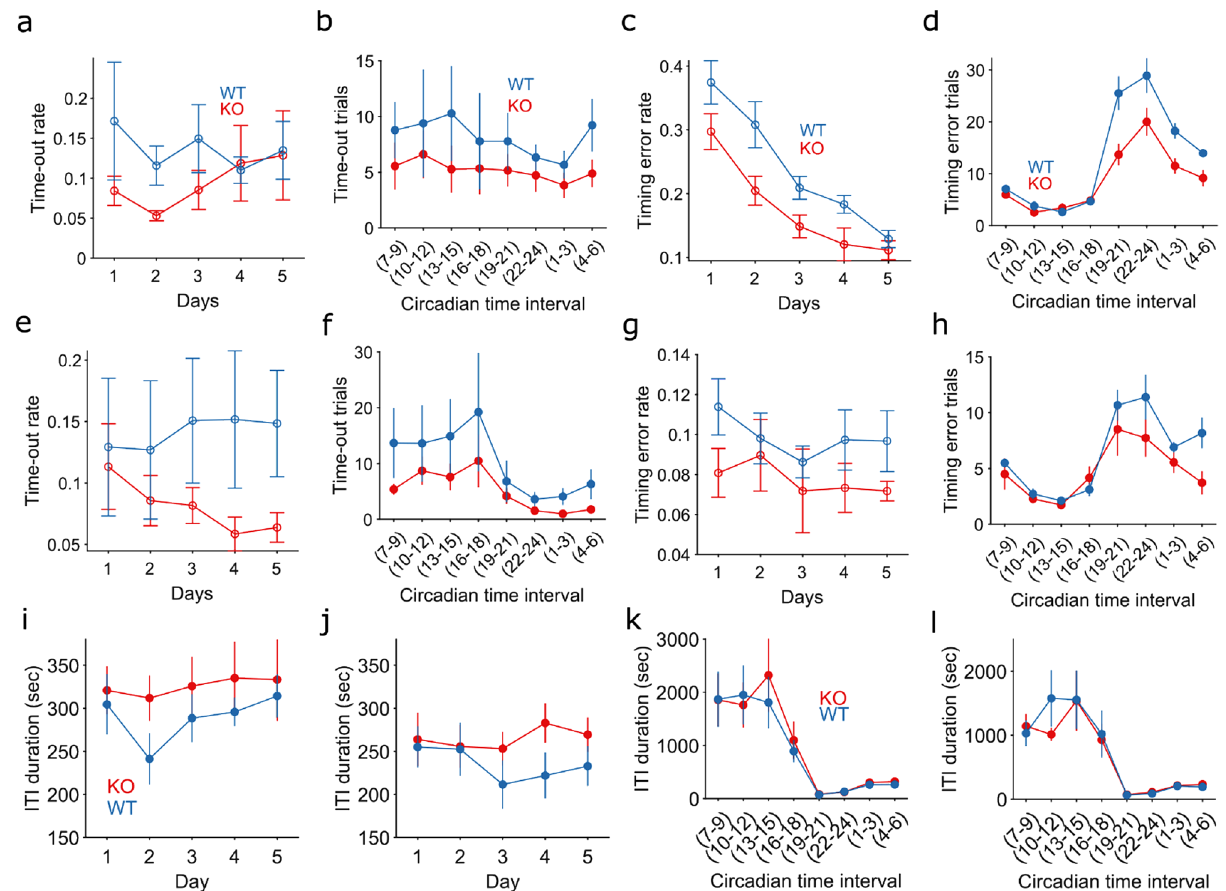
Figure 2. TAAR5 mice make fewer errors. ( a-d ). These panels refer to the first week of training. ( e–h ). Refer to the second week of training. Every panel shows mean ± SEM. Blue symbols are for wild-type mice, red symbols for KO mice. 2-way ANOVA has been used for every panel. ( a ). Time-out trial rate over the first week of training (no effect of time p = 0.77, F = 0.44 or group p = 0.09, F = 2.85). ( b ). Absolute number of time-out trials over the circadian cycle for three hours interval (no effect of time p = 0.92, F = 0.36, effect of group p = 0.02, F = 5.27). ( c ). Timing error rate over days of training (significant effect of time p < 0.005, F = 26.86 and effect of group p < 0.005, F = 18.23). ( d ). Absolute number of timing error trials over the circadian cycle (significant effect of time p < 0.005, F = 45.16, group p < 0.005, F = 24.56 and interaction p < 0.005, F = 3.71). ( e ). Similar to panel a. for the second week of training (no effect of time p = 0.99, F = 0.07, significant effect of group p = 0.02, F = 5.75). ( f ). Similar to panel b for second week of training (significant effect of time p = 0.03, F = 2.23, significant effect of group p = 0.02, F = 5.63). ( g ). Similar to panel c. (no effect of time p = 0.68, F = 0.57, significant effect of group p = 0.02, F = 5.61) ( h ). Similar to panel d (2-way ANOVA: significant effect of time p < 0.005, F = 12.01 and effect of group p = 0.01, F = 6.79). ( i ). Average ITI duration for each day during the first week of training (no effect of time p = 0.8, F = 0.38, or group p = 0.06, F = 3.53). ( j ). Similar to panel i for second week of training (no effect of time p = 0.6, F = 0.62, or group p = 0.08, F = 3.17). ( k ). ITI duration along the circadian cycle for intervals of three hours. (Significant effect of time p < 0.005, F = 12.56, no effect of group p = 0.6, F = 0.25.) ( l ). Similar to panel k for second week of training. (Significant effect of time p < 0.005, F = 12.56, no effect of group p = 0.6, F = trials and accurately performed trials. The efficiency of TAAR5-KO mice could depend on two factors. One is that they make fewer mistakes and potentially learn faster, suggesting that they are more efficient and engaged